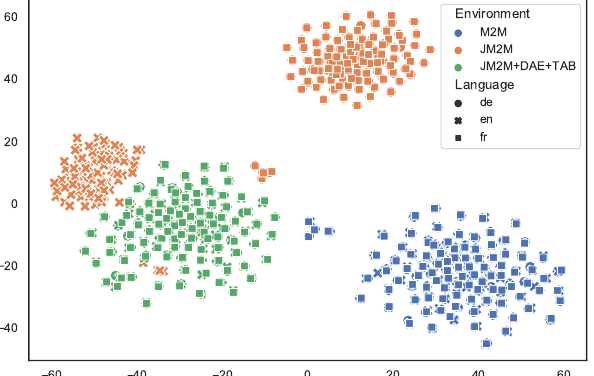
Figure 8. Interlingual representation of multi-parallel sentences from the M2 model trained in the M2M and JM2M environments and the proposed JM2M + DAE + TAB model.